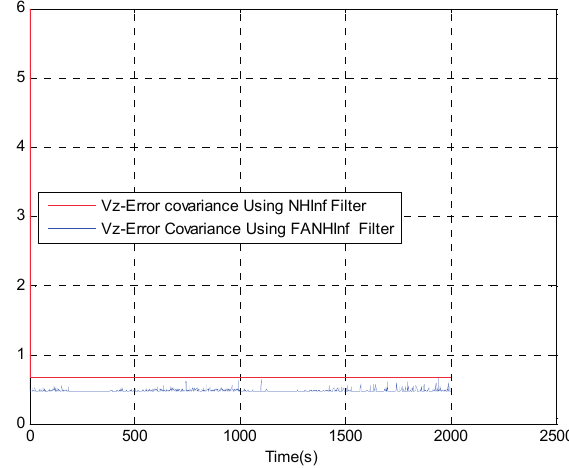
Figure 16. Velocity error covariance in z -axes.